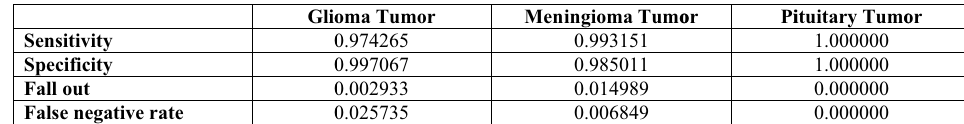
Figure 13: Sensitivity, speci fi city, fallout, and false negative rate of BKNN.